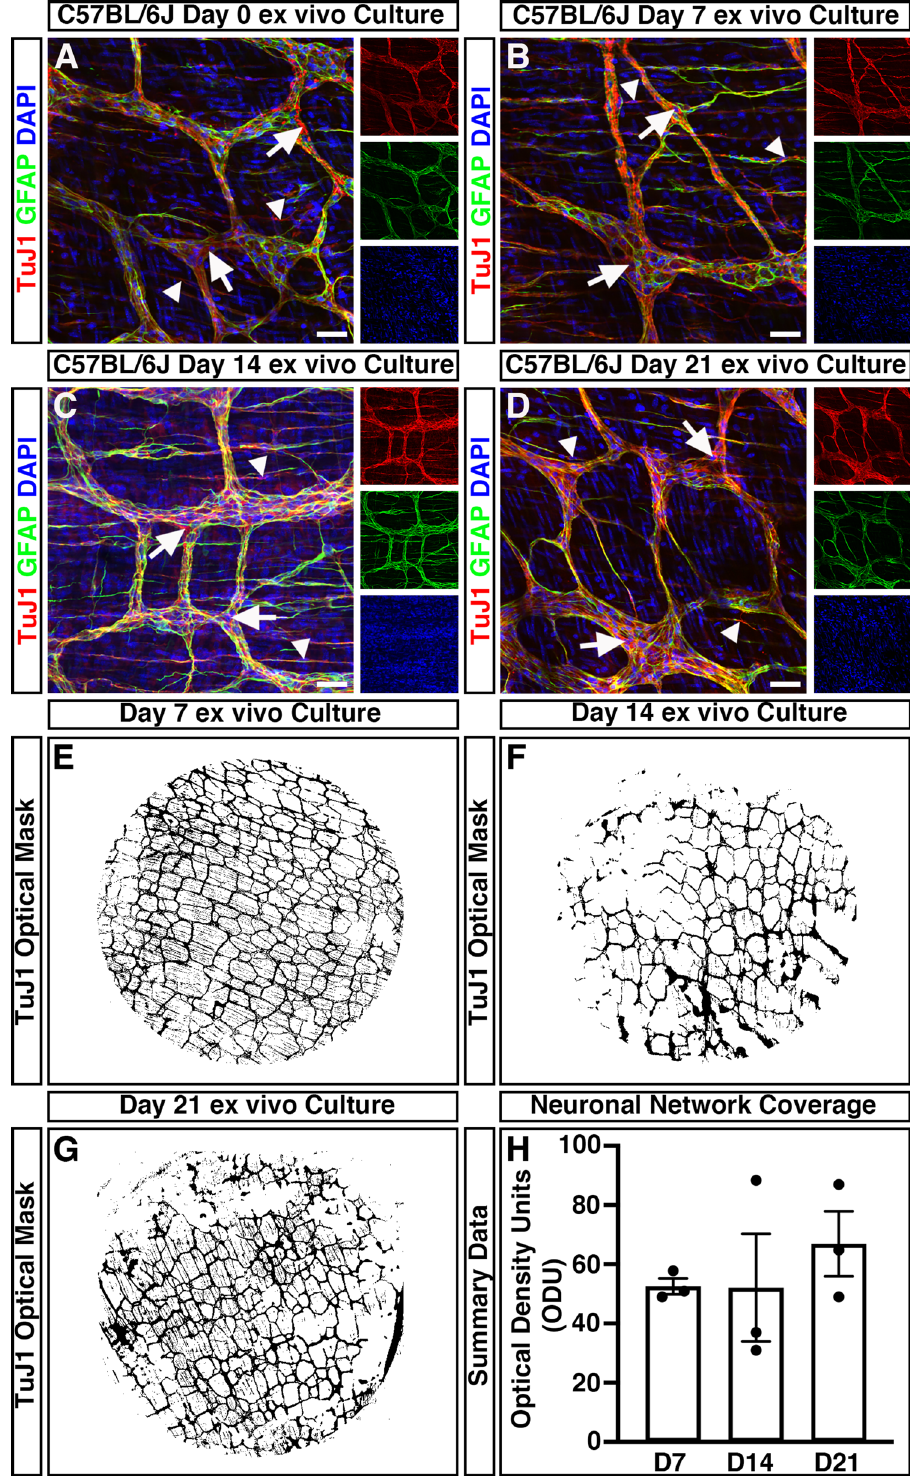
Figure 2. Mouse colonic segments cultured ex vivo maintain expression of ENS markers. ( A – D ) Representative confocal z-stack images demonstrating the presence of the pan neuronal marker; TuJ1 ( red ), glia marker; GFAP ( green ) and DAPI ( blue ) in fresh ( A ), Day 7 ( B ), Day 14 ( C ), and Day 21 ( D ) ex vivo cultured C57BL/6J colonic tissue. TuJ1 + expression was readily observed across organotypic culture and was found to label the ENS at the level of the myenteric plexus (arrows) and intramuscular nerves (arrowheads). ( E – G ) Representative optical density masks of montaged TuJ1 + expression within cultured colonic segments at Day 7 ( E ), Day 14 ( F ), and Day 21 ( G ). ( H ) Summary data of neuronal network coverage, as determined by the optical density of TuJ1 + expression, across organotypic culture (n = 3 for each timepoint). Error bars represent mean ± s.e.m. Scale bars represent 50